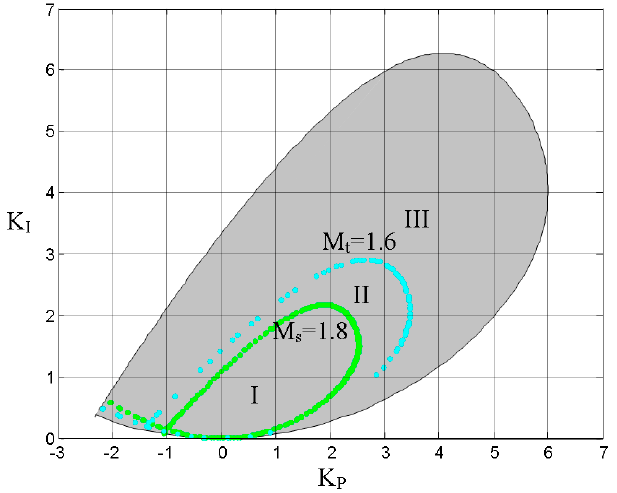
Figure 5. Stabilizing region and boundary curves ( M s = 1.8 and M t = 1.6) in the K P - K I parameter plane for PID α control of the non-minimum phase process in Equation (5).